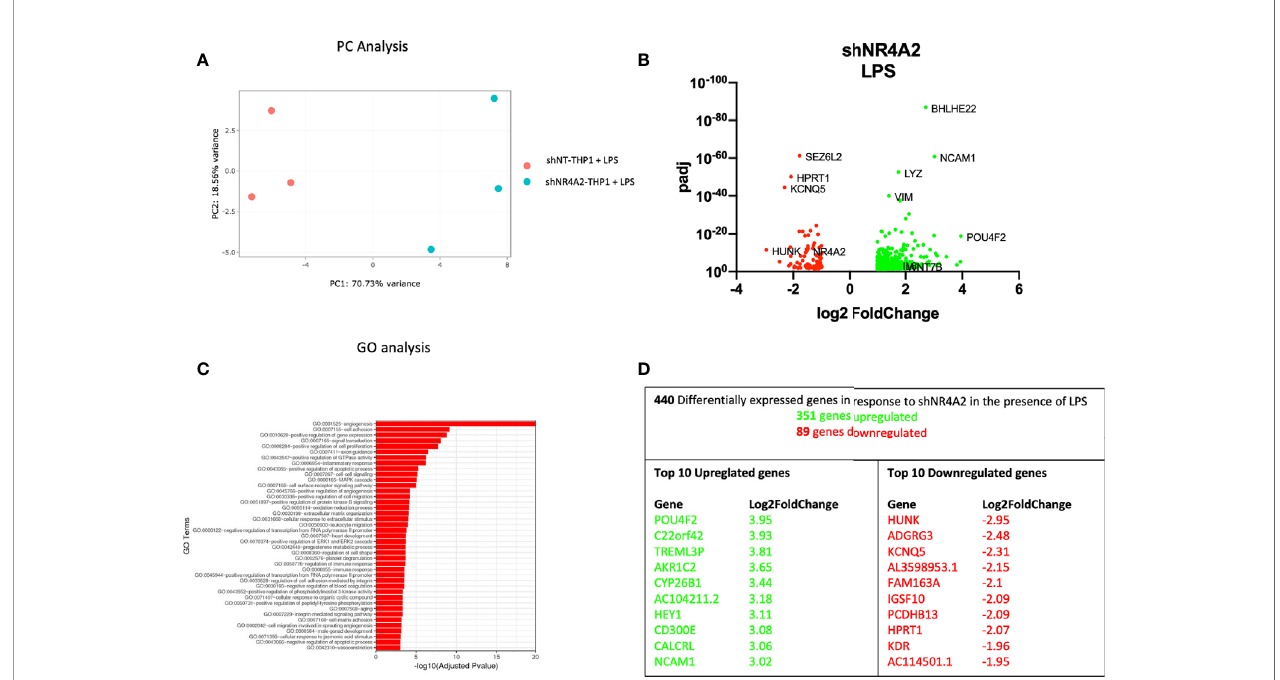
FIGURE 2 | Knockdown of NR4A2 has a distinct transcriptional pro fi le in the presence of LPS. Principal component analysis (PCA) plot of transduced cells based on RNA-seq data between shNT and shNR4A2 cells in the presence of LPS (A) . Volcano plot of signi fi cant DEGs (p<0.05) upregulated (log2fc>/=1) (green) or downregulated (log2fc</=-1) (red) by knockdown of NR4A2 in THP-1 cells in the presence of LPS based on RNA-seq data (B) . Top gene ontology (GO) terms associated with knockdown of NR4A2 in THP-1 cells in the presence of LPS based on RNA-seq data (C) . Summary table of signi fi cant DEGs upregulated (green) and downregulated (red) by knockdown of NR4A2 in THP-1 cells in the presence of LPS based on RNA-seq data (D)